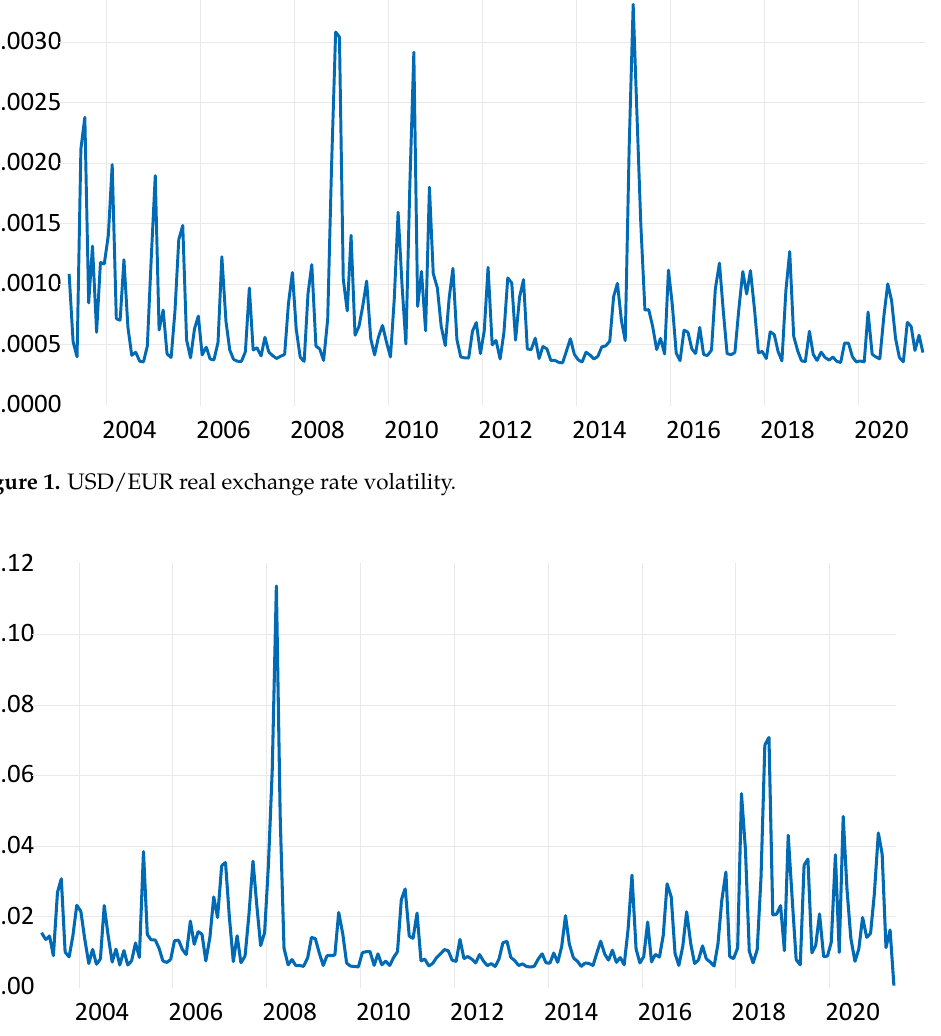
Figure 2. CNY/USD real exchange rate volatility.